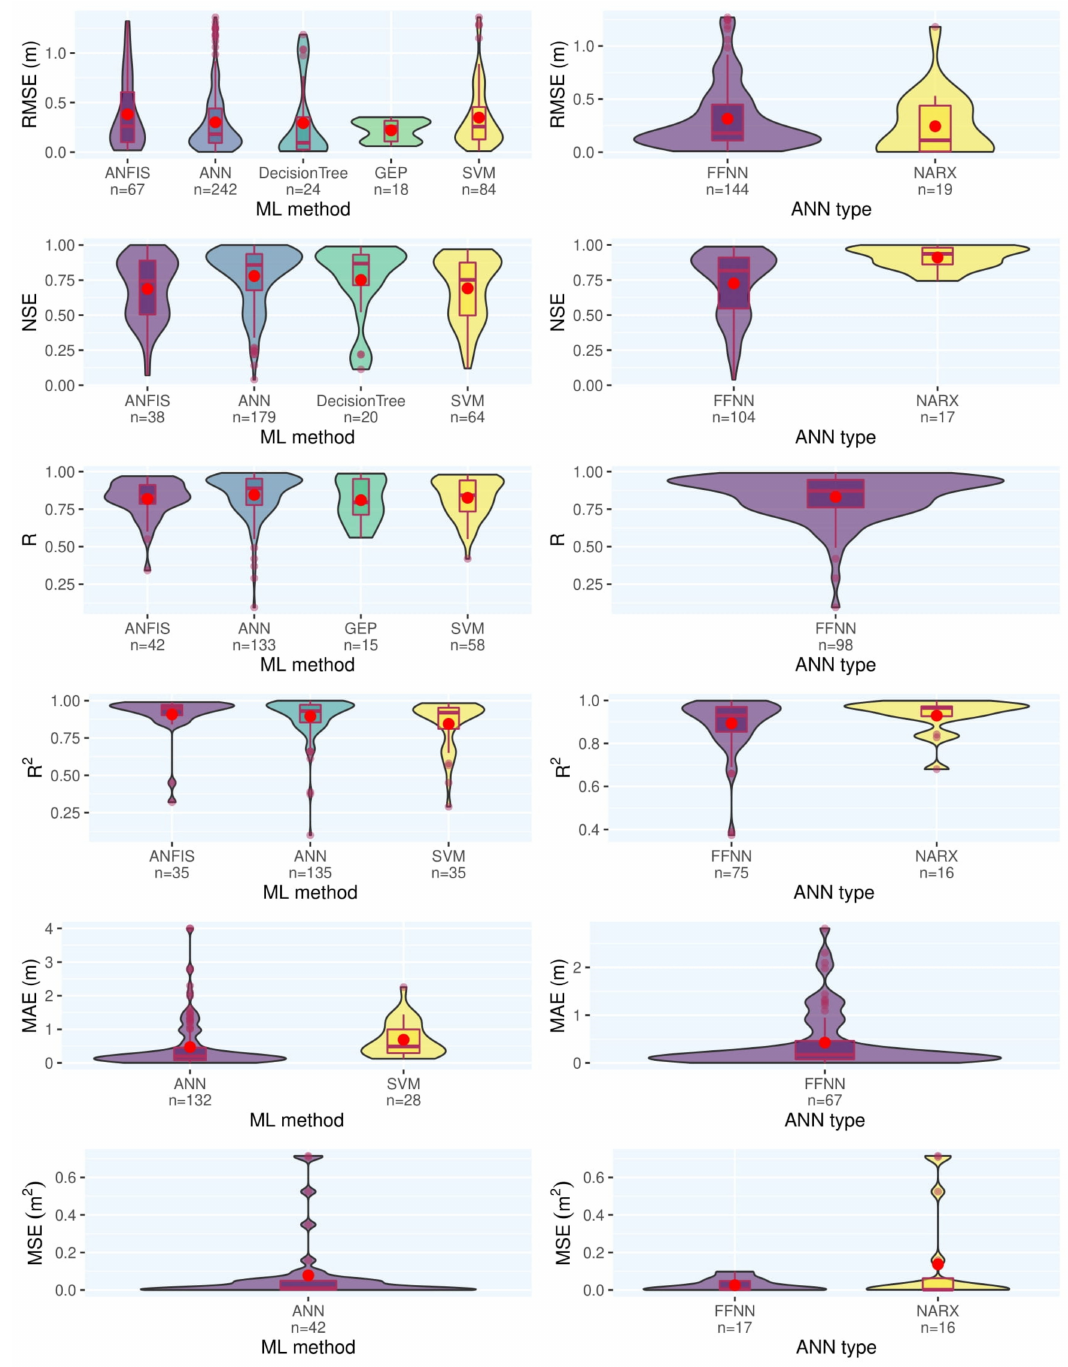
Figure 13. Results of meta-analysis for ML models and ANN architectures to predict groundwater